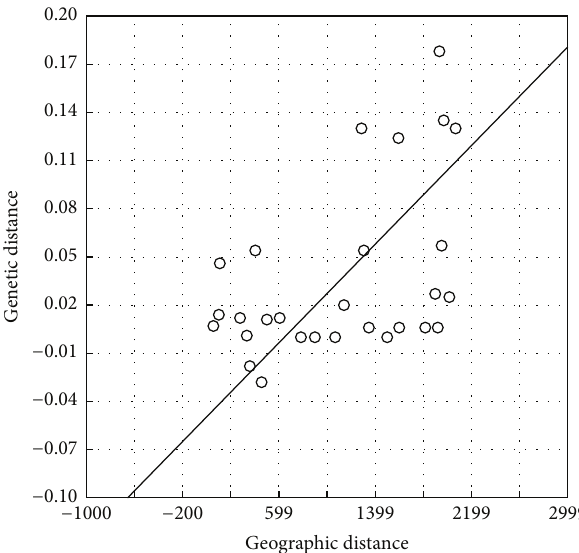
Figure 3: Plot of genetic distance versus geographical distance (in Kms.) for analysing isolation-by-distance patterns in T. ilisha .